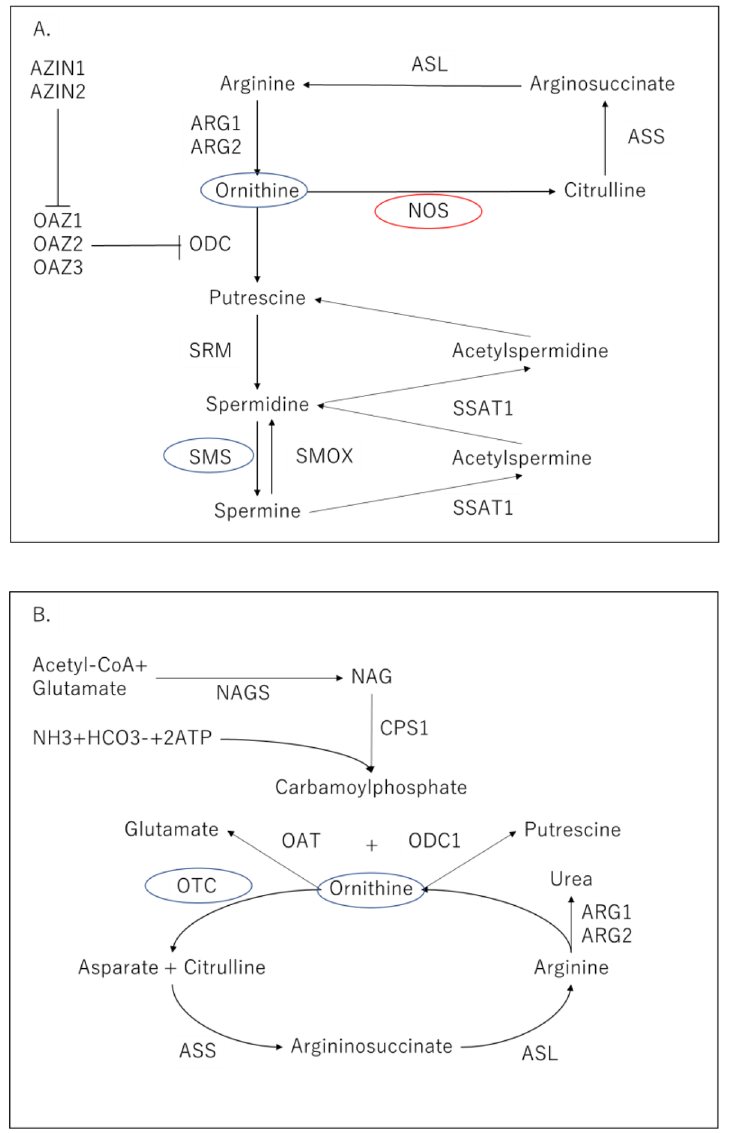
Figure 4. Polyamine pathway and urea cycle. ( A ) The polyamine pathway in mammalian cells (33,586,680 Fig. 1) ARG1: arginase1, ARG2 arginase2, ODC ornithine decarboxylase, SRM spermidine synthase, SMS spermine synthase, SMOX spermine oxidase, AZIN1 antizyme inhibitor 1, OAZ1 ornithine decarboxylase antizyme 1, SSAT1 spermidine/spermine N1-acetyltransferase 1, NOS nitric oxide synthase, ASL argininosuccinate lyase, ASS argininosuccinate synthase. ( B ) Urea cycle (31,978,055 Fig. 1) NAG N-acetyl glutamate, NAGS N-acetylglutamate synthase, CPS1 carbamoyl phosphate synthetase I, OAT ornithine aminotransferase, ornithine aminotransferase, ODC1 ornithine decarboxylase 1, OTC ornithine